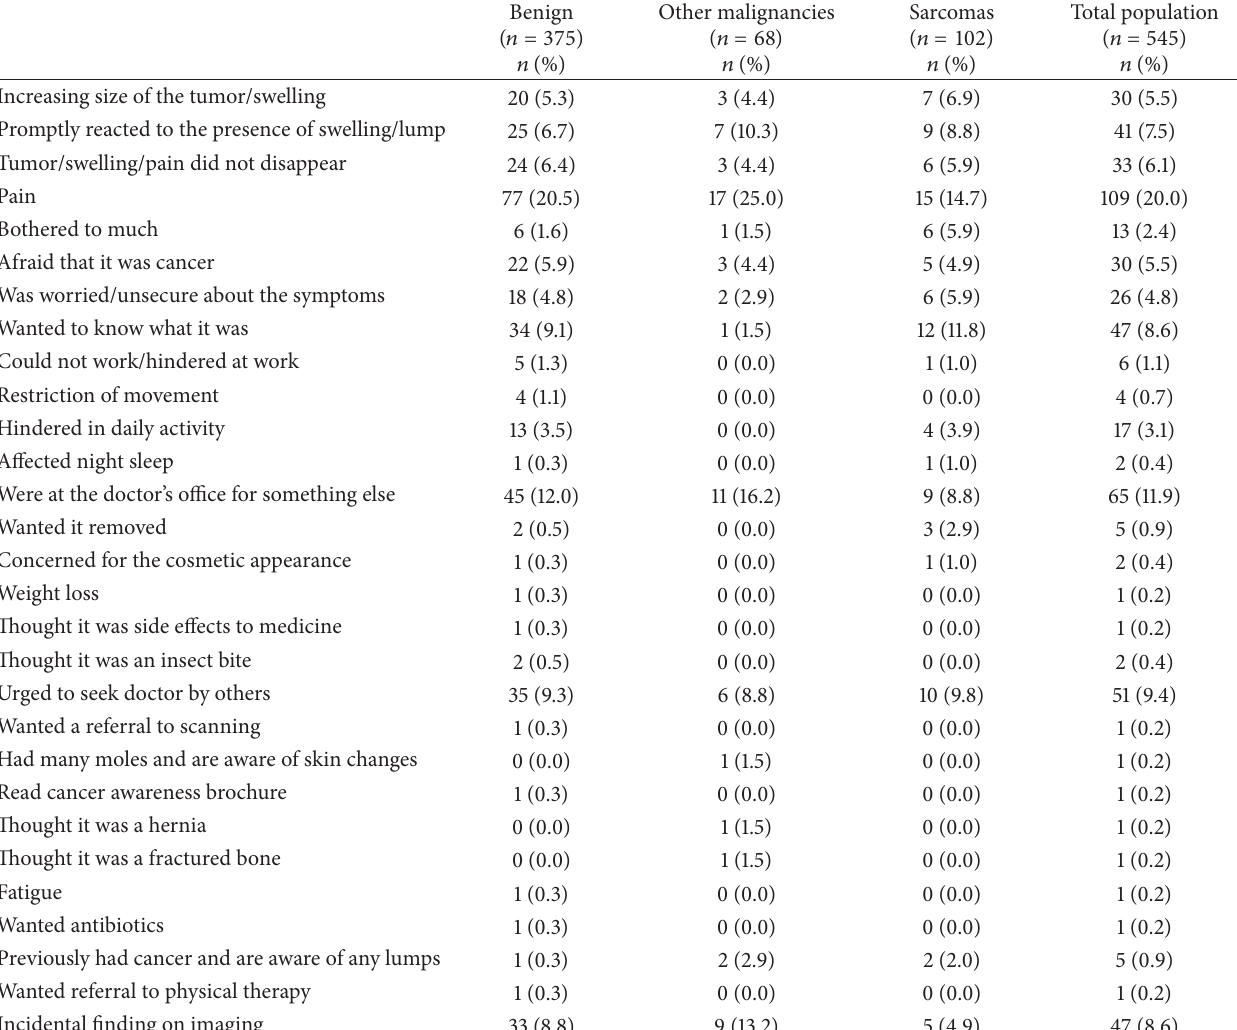
Table 2: Main reason for seeking medical care as stated by the